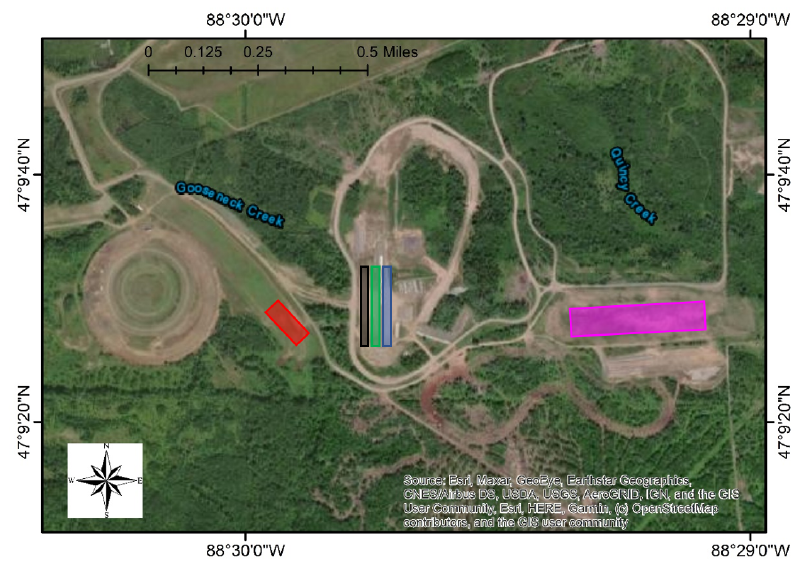
Figure 1. The locations of the five soil pits at KRC are highlighted. Boxes show the area of the soil pits: Fine (red), Coarse (blue), Rink (green), Stability (purple), and 2NS (black). Table 1. Keweenaw Research Center (KRC) Soil Information. % Gravel, % Sand, % Fine, D10, D30, D60, Cu, Cc, and Unified Soil Classification for Soil (USCS) Classification. Fine Coarse